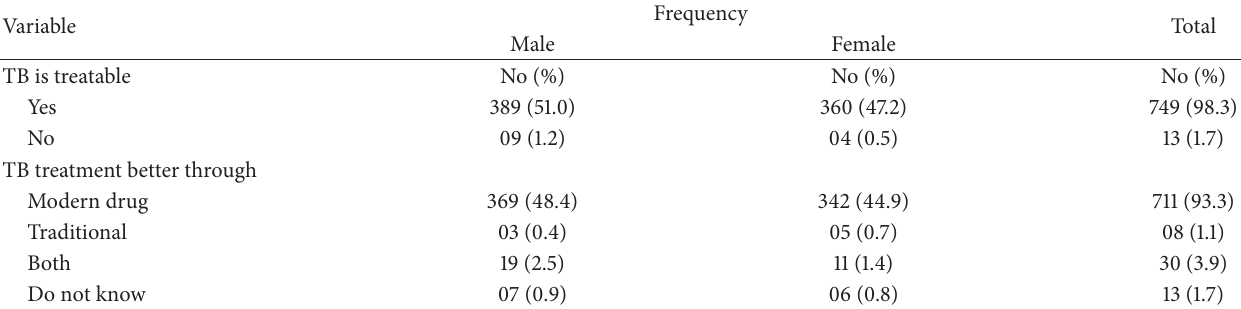
Table 4: Percentage distribution of respondents’ knowledge regarding TB treatment ( 𝑛 = 762 ).